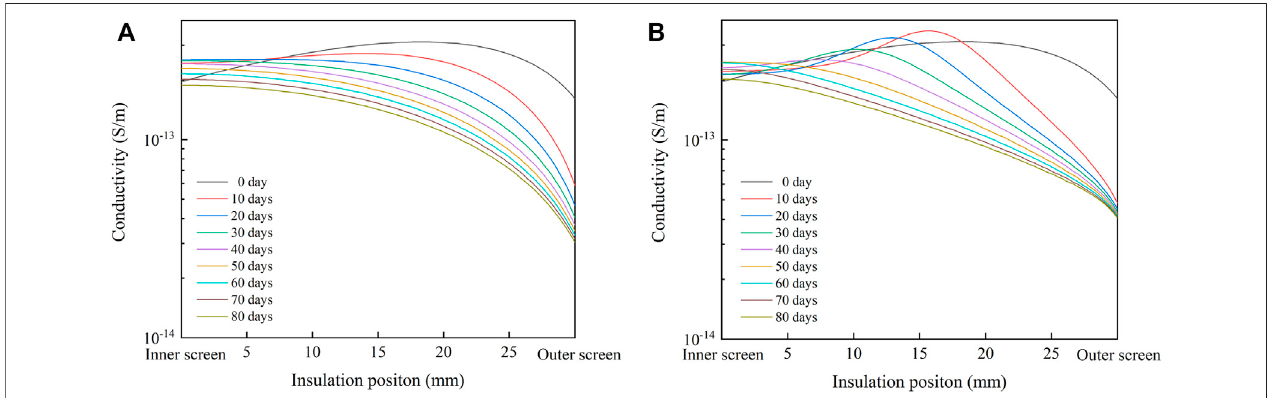
FIGURE 7 | Radial conductivity distribution of cable insulation under 30 ° C and 20 kV/mm. (A) Single well model; (B) double well